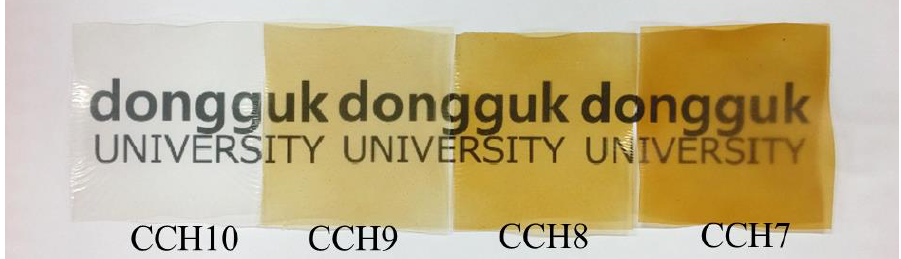
Figure 1. Photo of the CCH films.